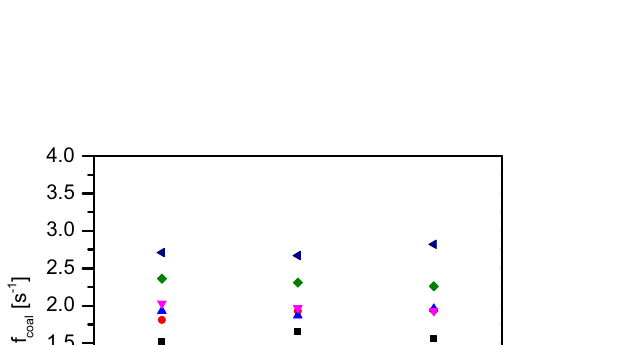
◦ C (downward magenta triangles), 60